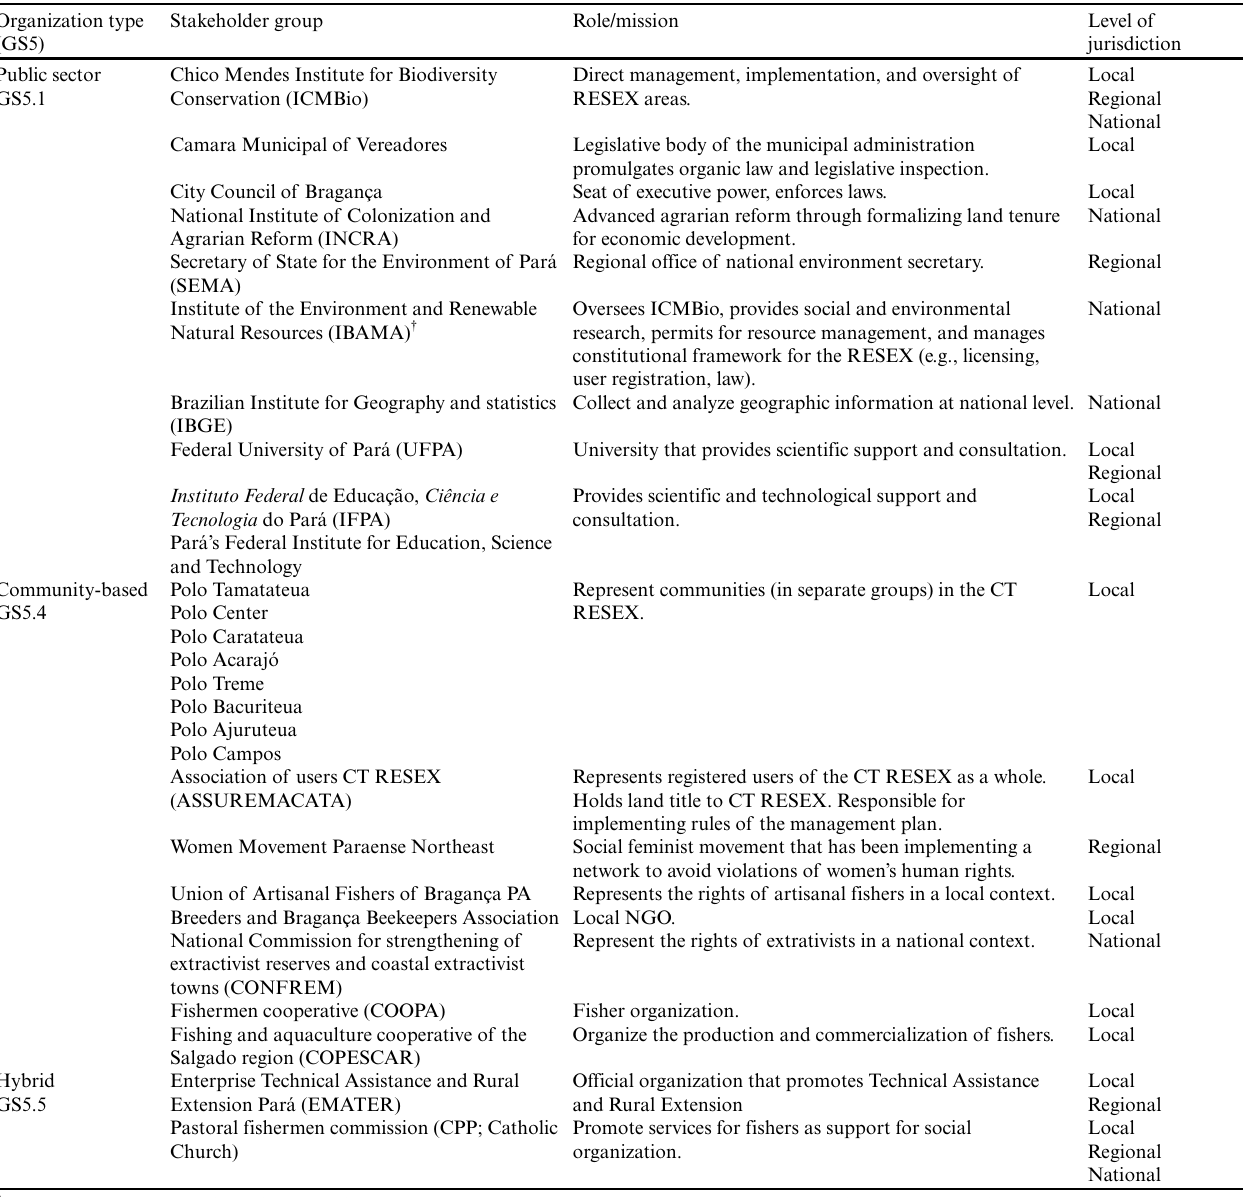
Table 2 . Stakeholder groups, each with one seat on the RESEX Deliberative Council (RESEX = marine extractive